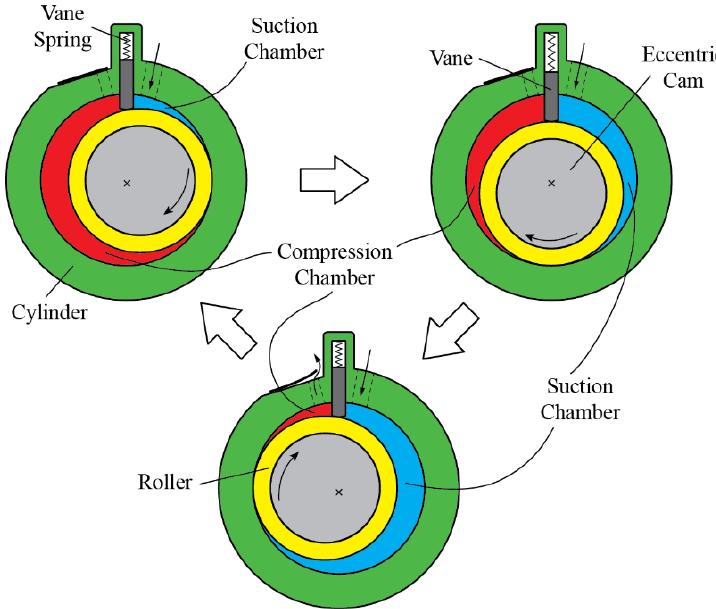
Figure 3. Rolling piston compressor working principle.